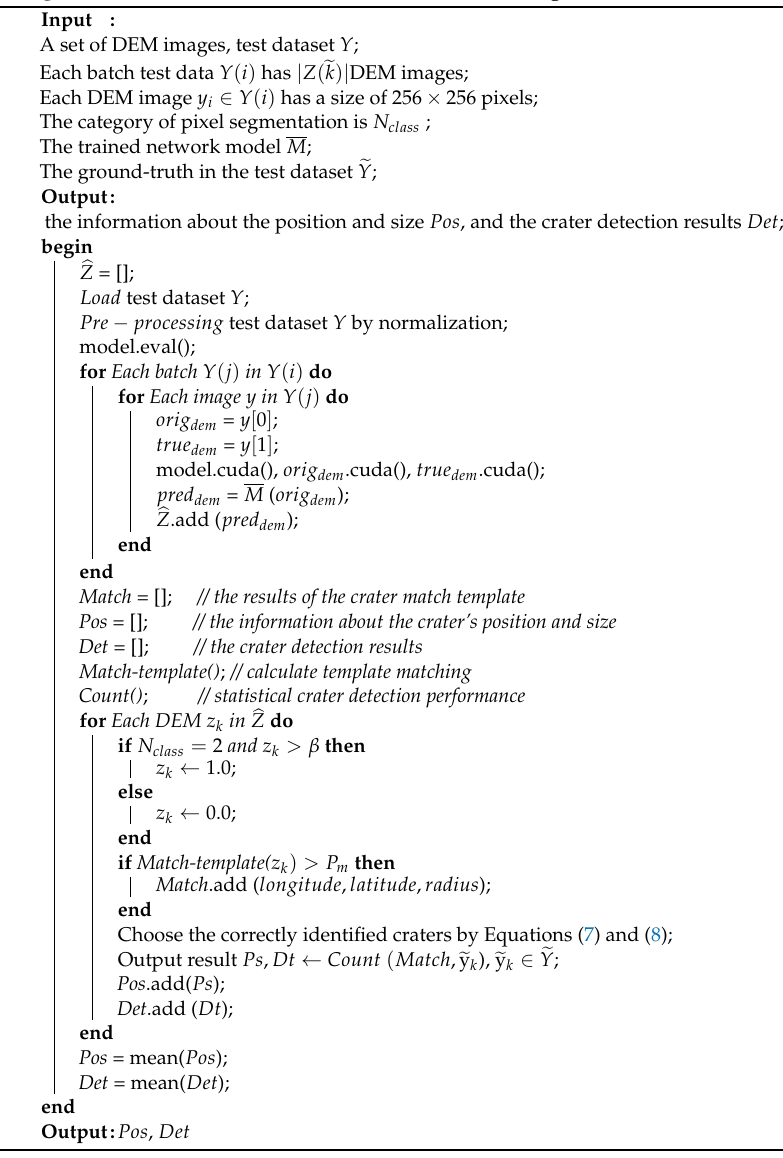
Algorithm 1: Efficient Lunar Crater Detection